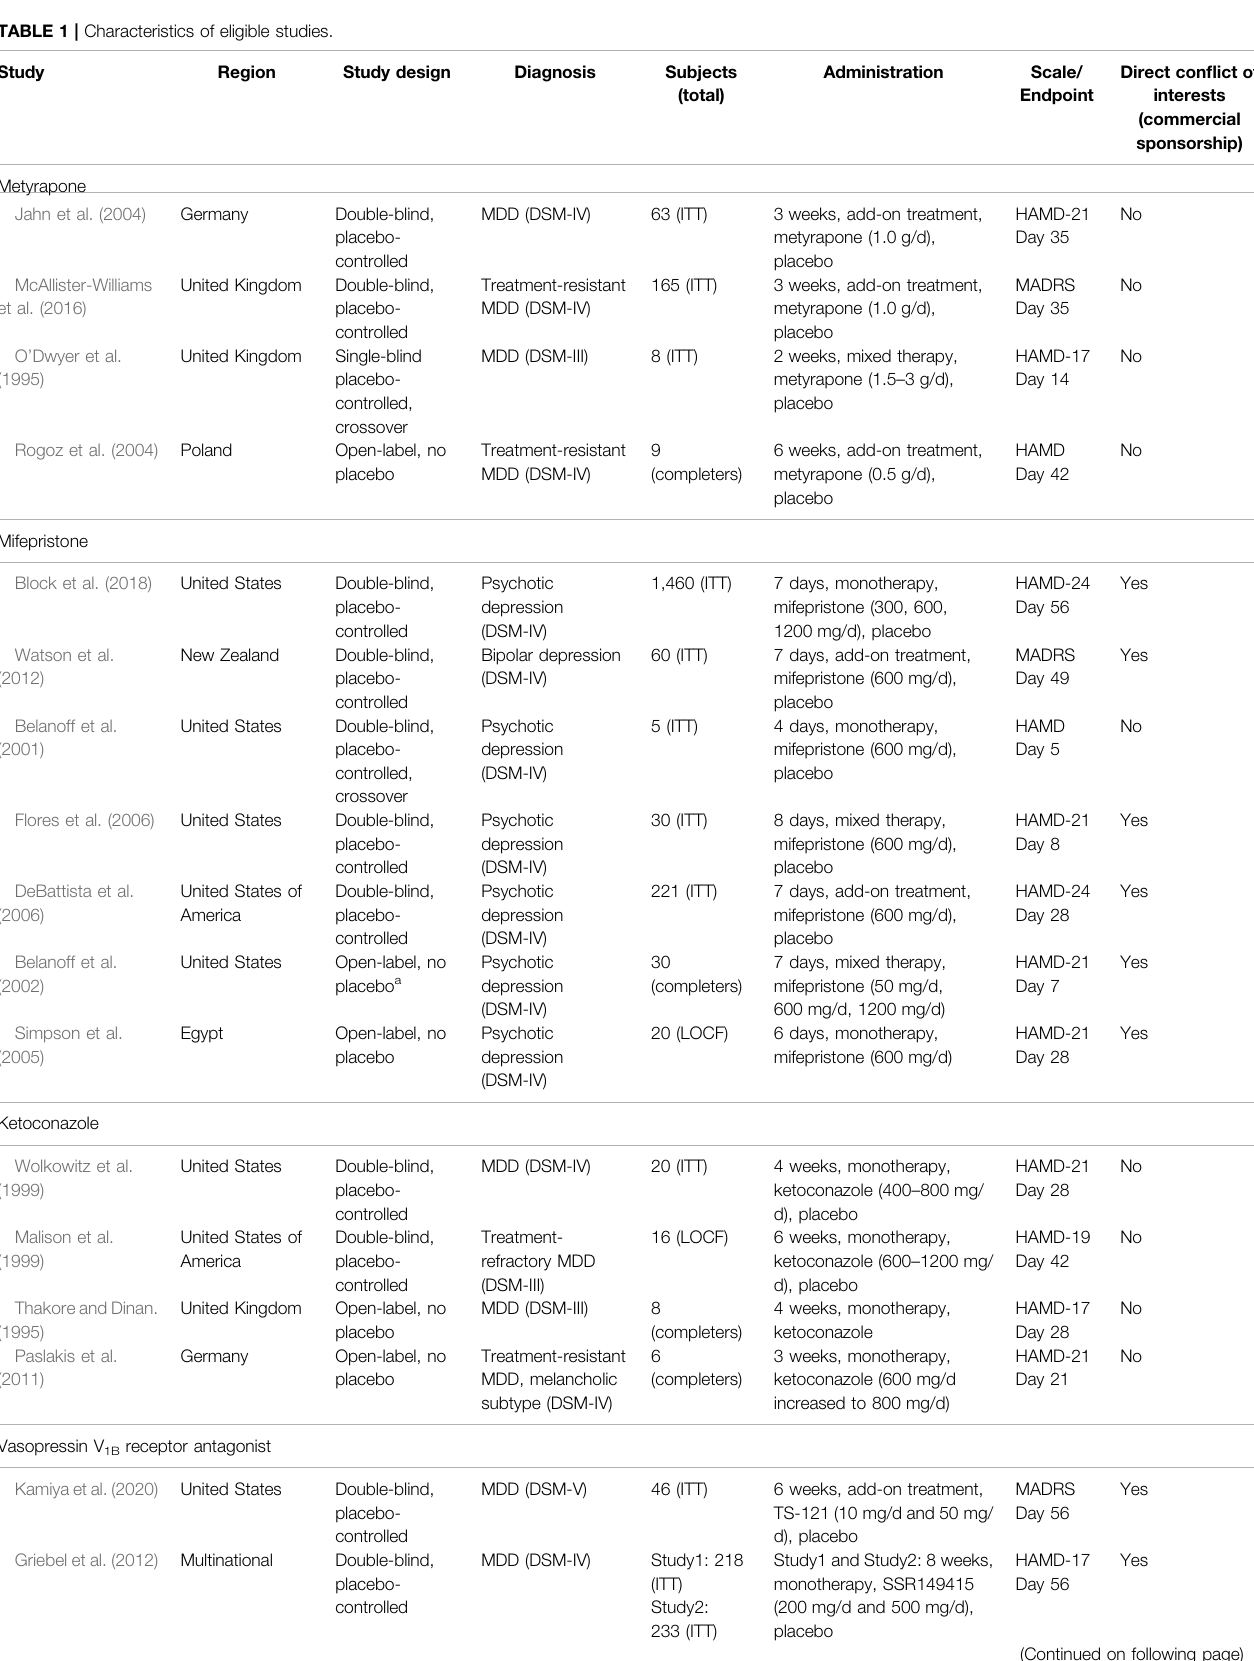
TABLE 1 | Characteristics of eligible